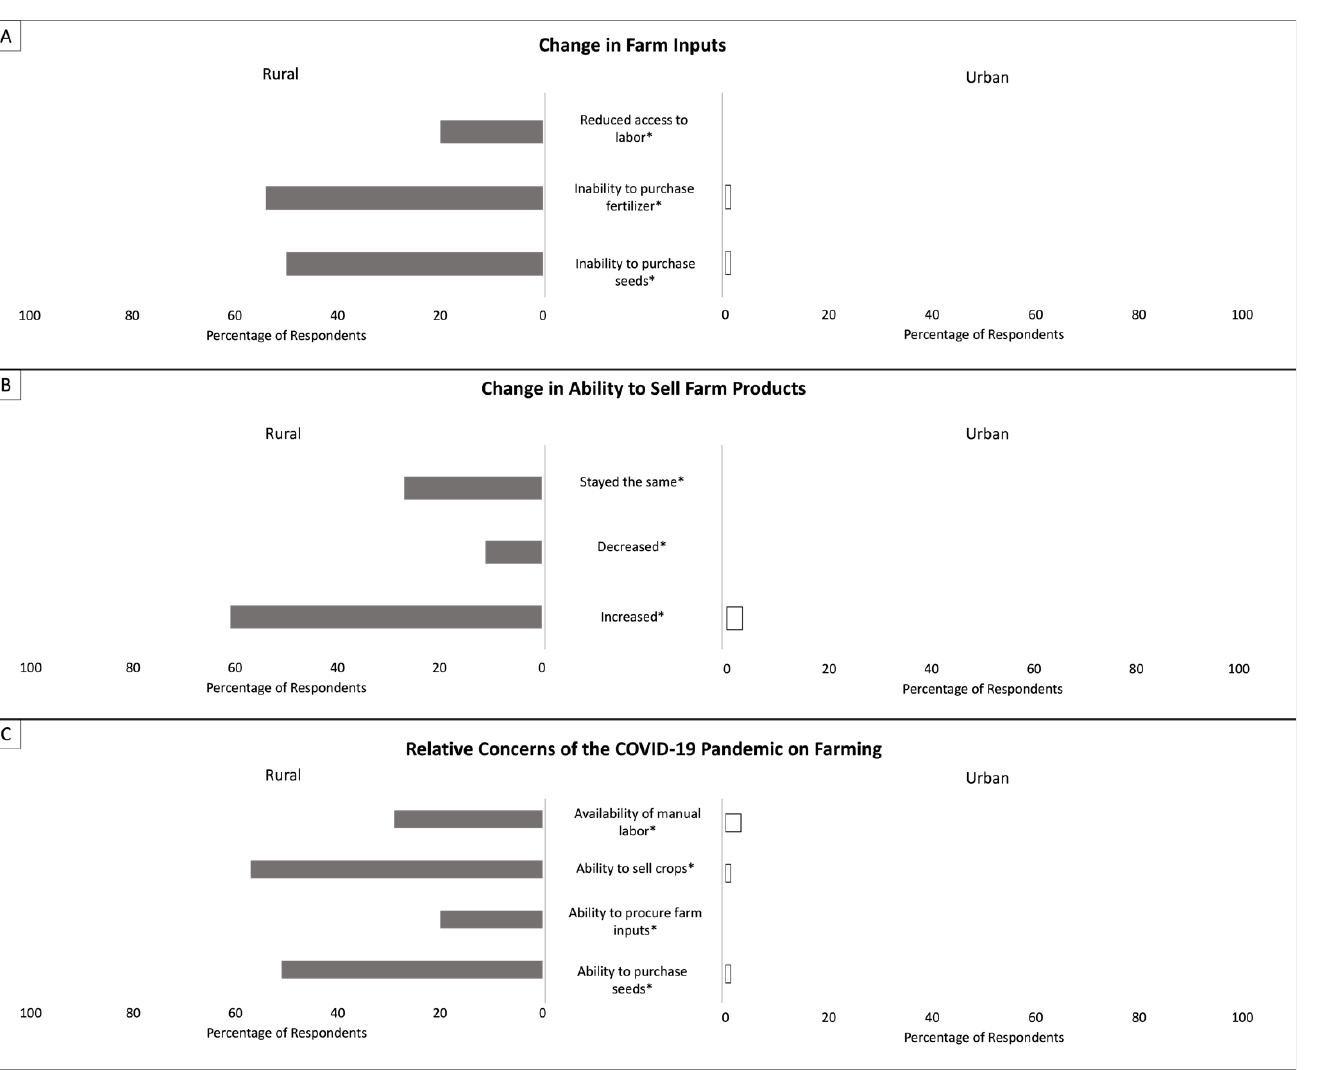
Figure 1. Impact and concern of the COVID-19 pandemic on agricultural practices in urban ( n = 144) and rural ( n = 173) Kenya. * Statistically significant at p < 0.05 ( χ 2 test). ( A ) Change in reported farm inputs. Multiple answers were recorded. ( B ) Change in ability to sell farm products. ( C ) Relative concerns of the COVID-19 pandemic on farming. Multiple answers were recorded.